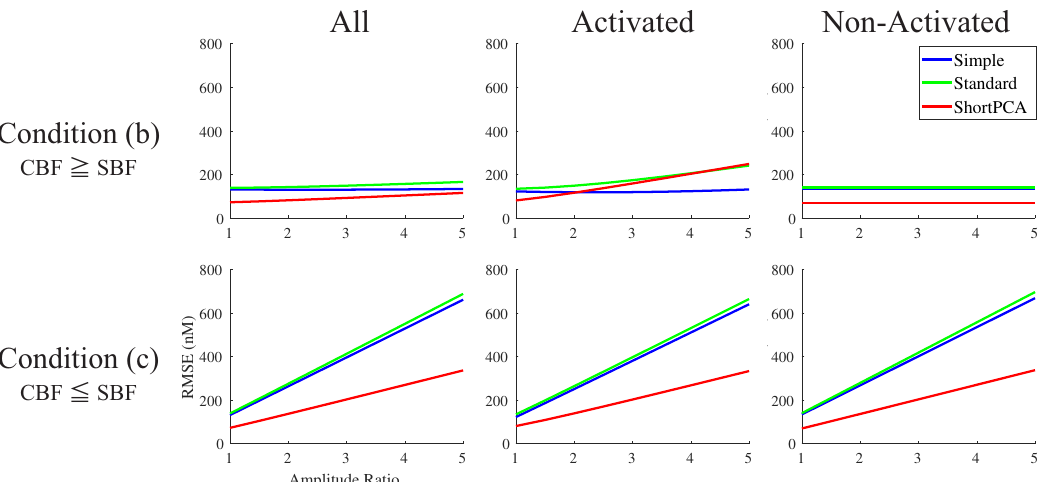
Figure 5. RMSE in several amplitude ratios between cerebral blood flow (CBF) and scalp blood flow (SBF). RMSE of each case was averaged across three-channel sets: all (43 long-channels), activated (11 long-channels containing evoked CBFs) and non-activated (32 long-channels containing no